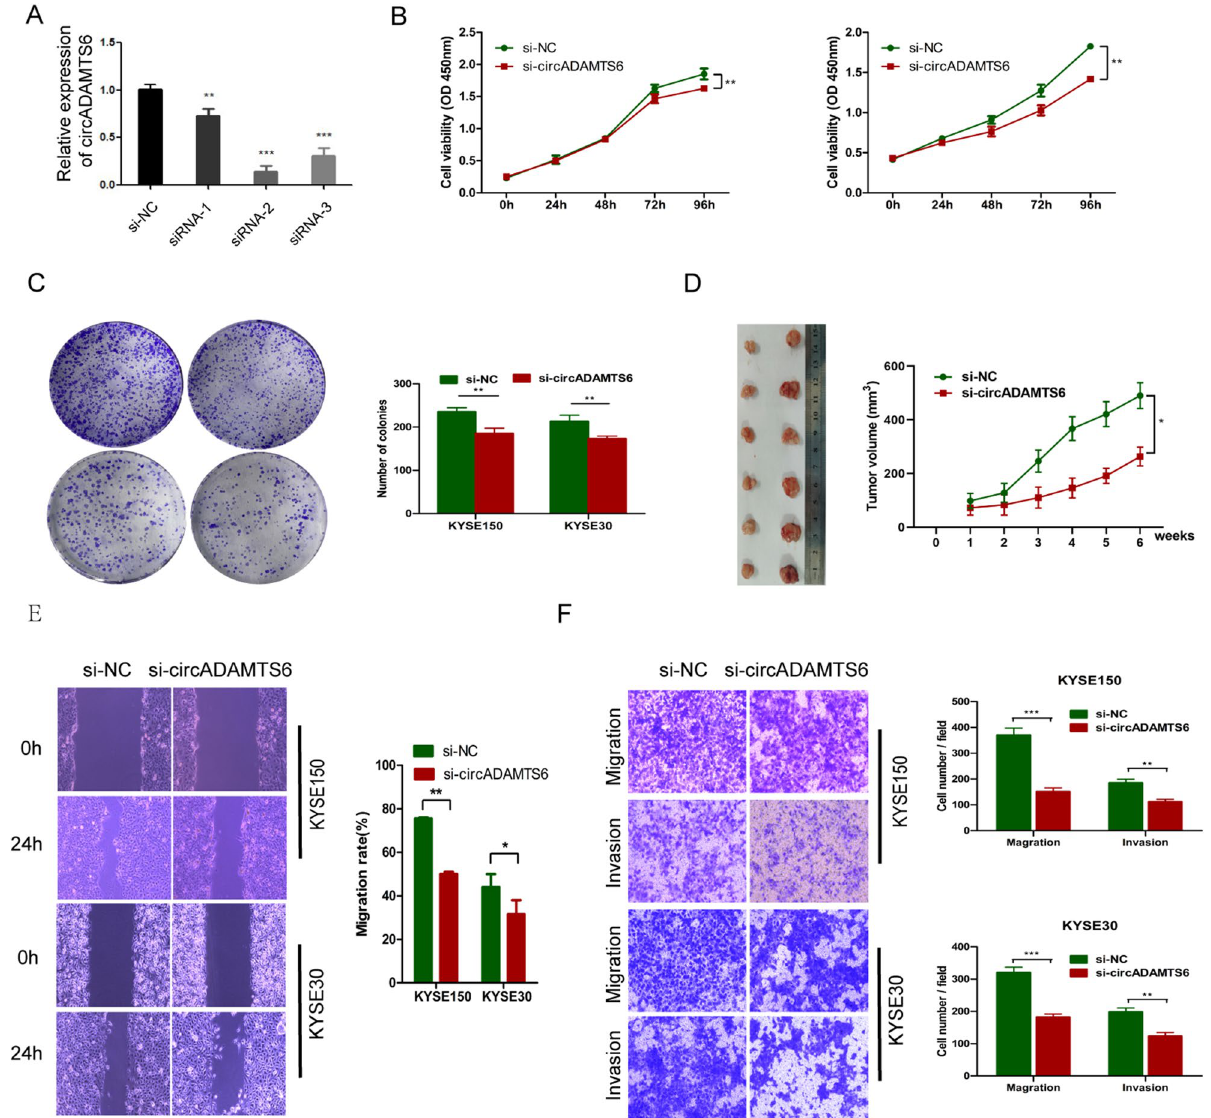
Figure 2. Knockdown of circADAMTS6 inhibits the ability of cell proliferation, migration and invasion in ESCC cells and tumor formation in vivo. ( A ) Relative expression level of circADAMTS6 transfected with si-NC and si-circADAMTS6 in KYSE150 cell. ( B , C ) Cell proliferation was assessed by CCK8 and colony formation assay after down-regulation of circADAMTS6. ( D ) Representative photographs and tumor growth curves of subcutaneous xenograft tumor model developed from KYSE150 cell with si-NC and si-circADAMTS6 (n = 6). The tumor volumes were calculated according to the formula (L × W 2 )/2. ( E , F ) Knockdown circADAMTS6 repressed migration and invasion of ESCC cells. (* P < 0.05, ** P < 0.01, *** P < ESCC patients with clinicopathological and follow-up dates were obtained on Tissue Microarrays (TMAs). Circ- ADAMTS6 positive cells were stained red and the nuclei were stained with DAPI in blue. Representative images of H&E and FISH staining of circADAMTS6 expression in ESCC tissues and adjacent normal tissues were dis- played (Fig. 3). The outcomes indicated that circADAMTS6 was notably overexpressed in most ESCC tissues (n = 114; 81/114), which were great different from adjacent normal tissues (n = 66, 16/66). CircADAMTS6 is related to clinicopathological characteristics and OS in ESCC patients. The clinicopathological characteristics of ESCC patients in tissue microarrays were displayed in Supplementary Table 1. Our research discovered the positive expression rate of circADAMTS6 in ESCC tissues and adjacent normal tissues were 71.1% (81/114) and 24.2% (16/66), indicating that circADAMTS6 was more frequently expressed in ESCC tissues. The connection between circADAMTS6 levels and the clinicopathological charac- teristics of ESCC was investigated (Table 1). The high expression level of circADAMTS6 was closely related to advanced clinical stage, poor pathological grade, large tumor size and lymph node metastasis ( P < 0.05), but not